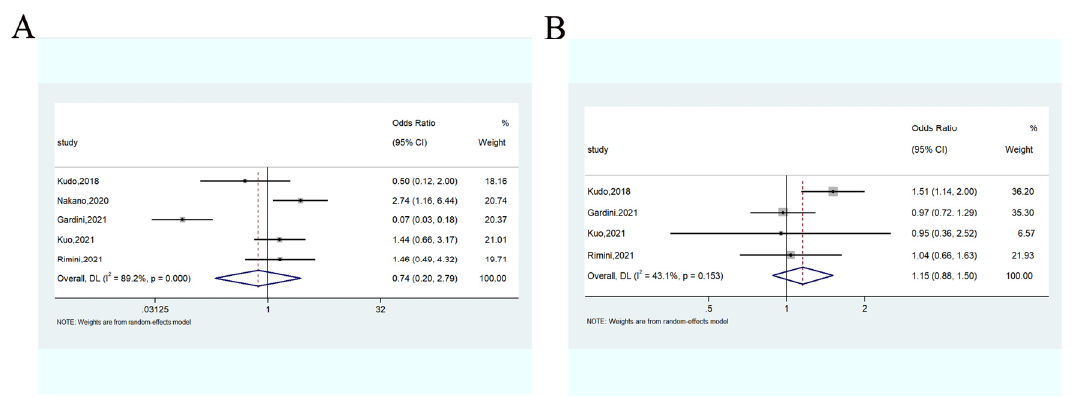
Figure 7. Forest plots of the all-grade ( A ) and severe adverse events ( B ) associated with lenvatinib vs.